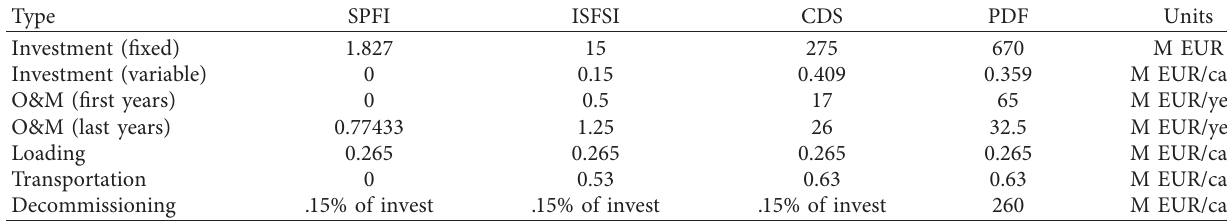
Table 7: Summary of cost assumptions.